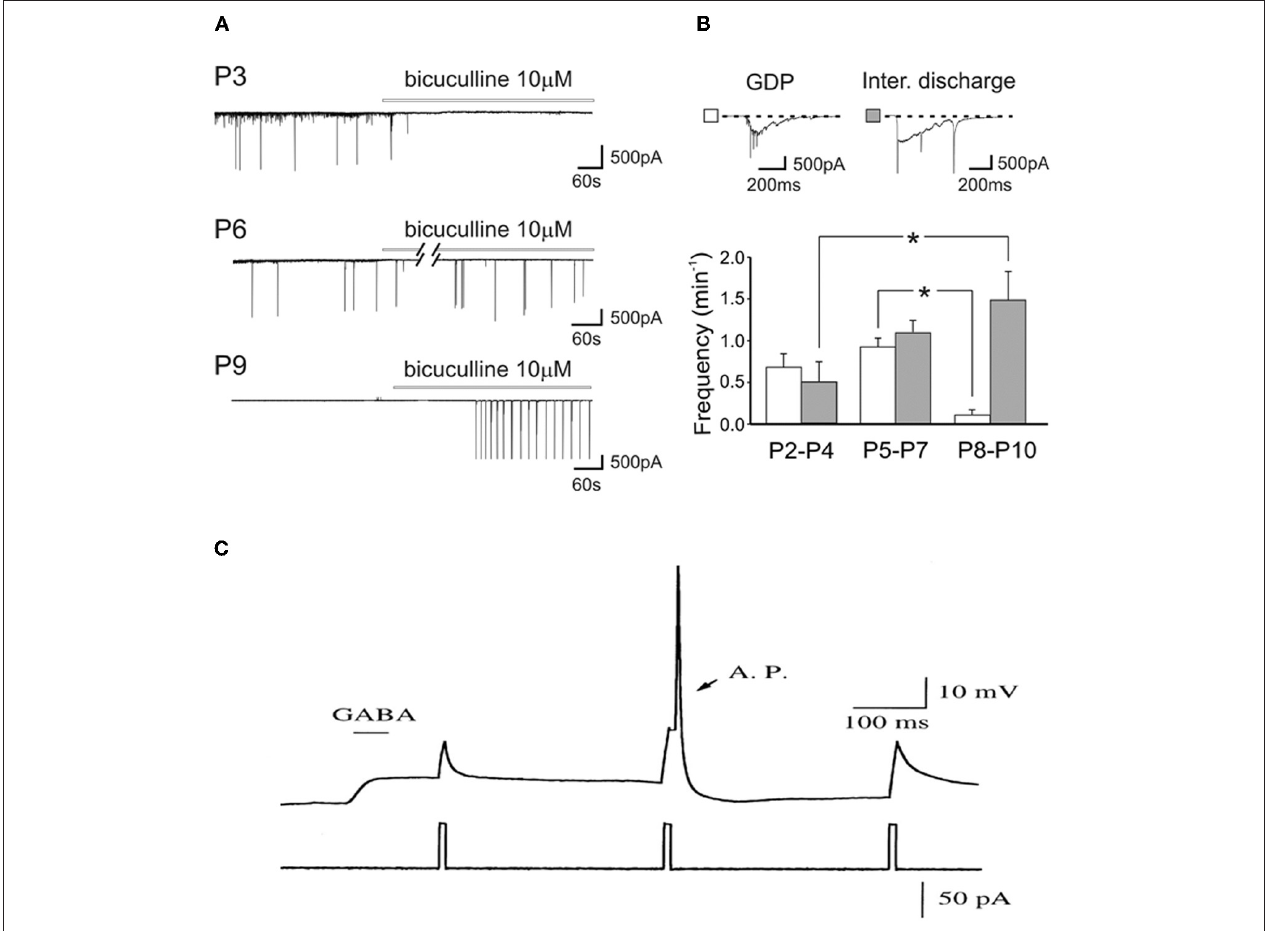
FIGURE 5 | Dual actions of GABA in the developing brain. (A) Representative traces recorded from CA1 pyramidal neurons in hippocampal slices obtained at P3, P6, and P9, in control conditions and during bath application of bicuculline (bars). Note the disappearance of GDPs with bicuculline at P3 but not at P6 and P9. (B) Frequency histograms of GDPs (white columns) and interictal bursts (gray columns) recorded at different times of postnatal development. Insets above the graph: a giant depolarizing potential (GDP) and an interictal discharge shown on an